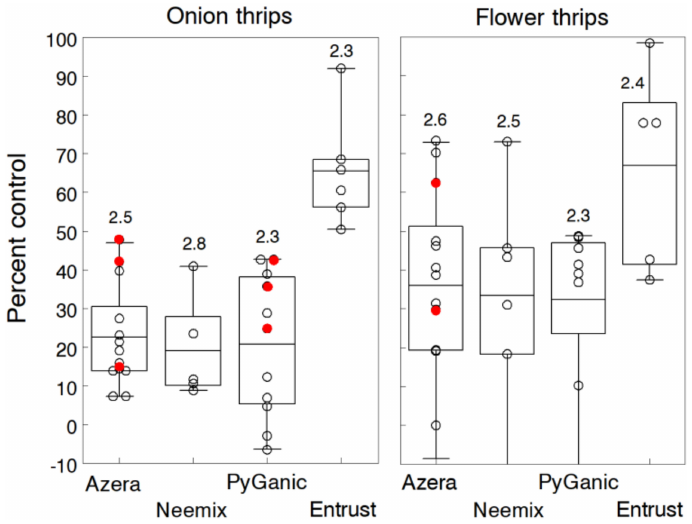
Figure 1. Percent control of onion and flower thrips with weekly applications of Azera, Neemix, PyGanic and Entrust relative to the untreated control. Mean data for each insecticide are given for 8 and 10 trials on onion and zinnia, respectively. Box-whisker plots show the 25% and 75% percentile range of percent control data and the horizontal line in each box is the overall mean control e ffi cacy. Number above each plot indicates the average number of weekly applications. Application rates of Azera, Neemix, PyGanic and Entrust were 2.34 L / h, 1169 mL / h, 2.34 L / h and 71.2 g a.i. / h respectively, except for trial data in red indicating a higher rate. Entrust provided significantly higher control of onion thrips compared to the other insecticides. There were no significant di ff erences among treatments for flower